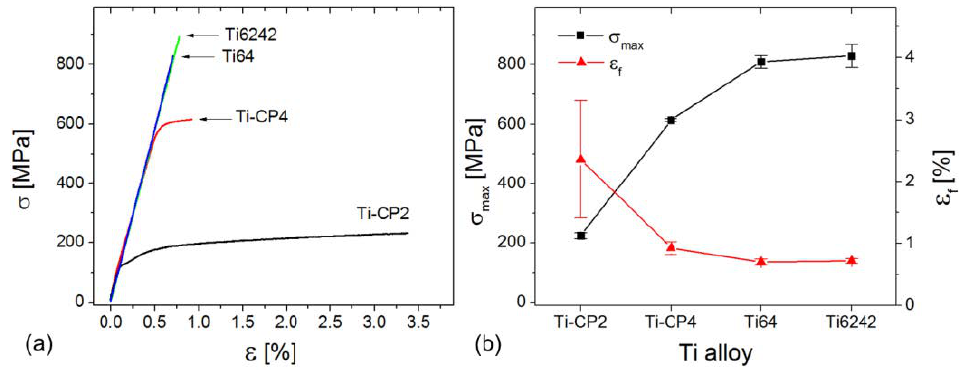
Figure 5. ( a ) Typical stress-strain curves of the joints, ( b ) tensile strength σ max and elongation at fracture ε f of the joints. An average from three test specimens is